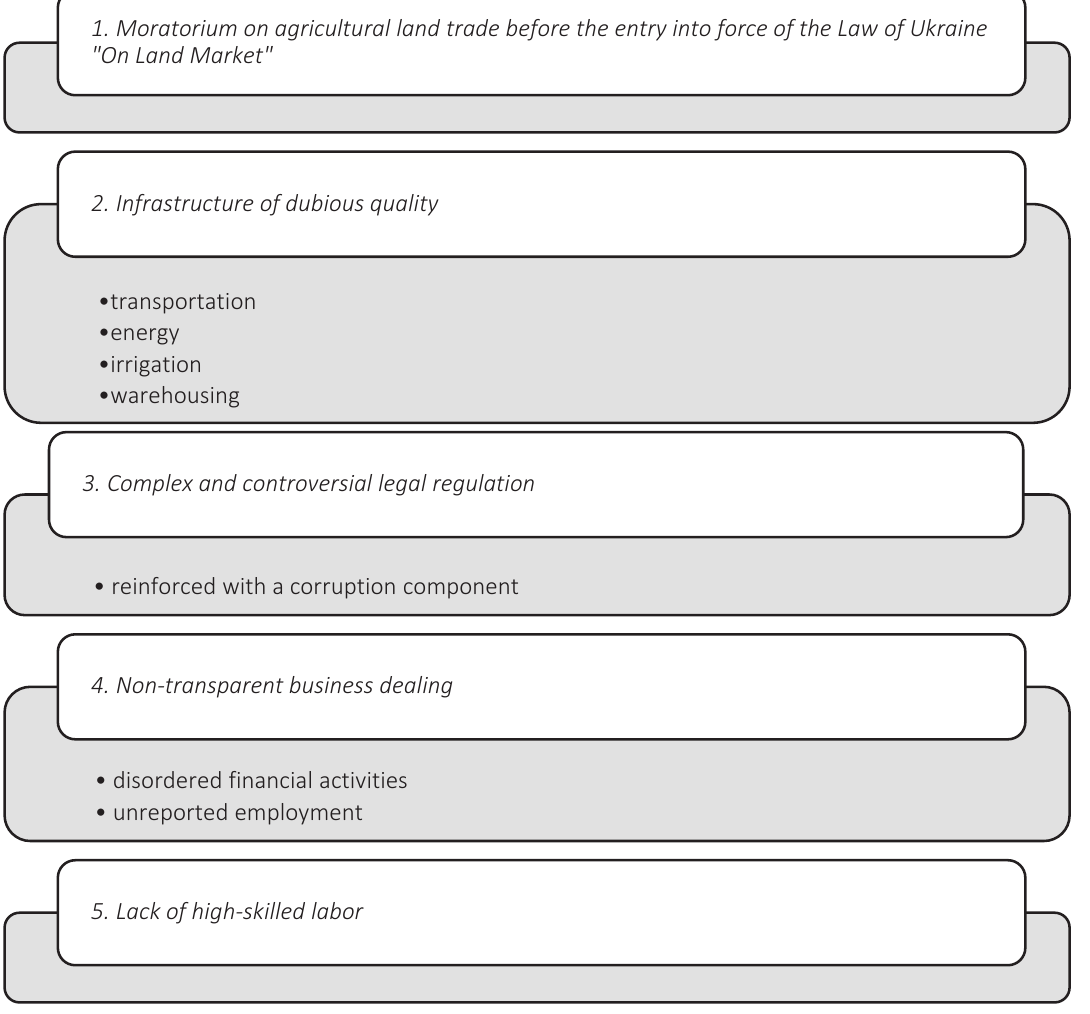
Figure 2. Factors hindering the attraction of foreign investment in the agricultural business in